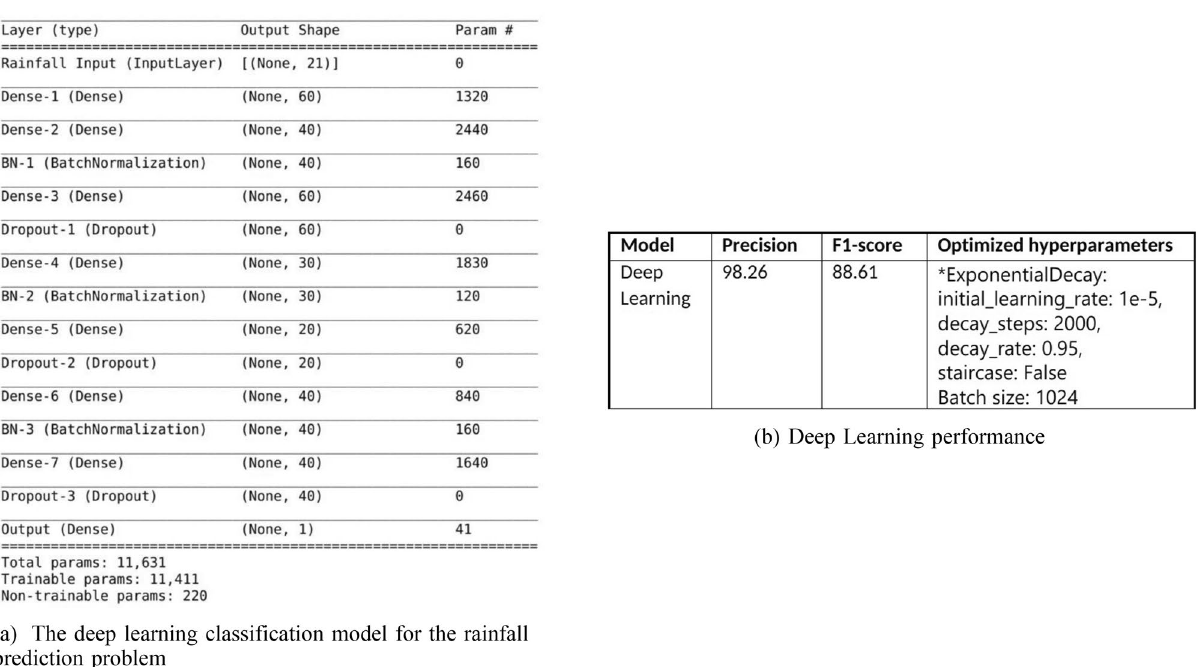
Figure 18. Bernoulli Naïve Bayes performance and feature set.